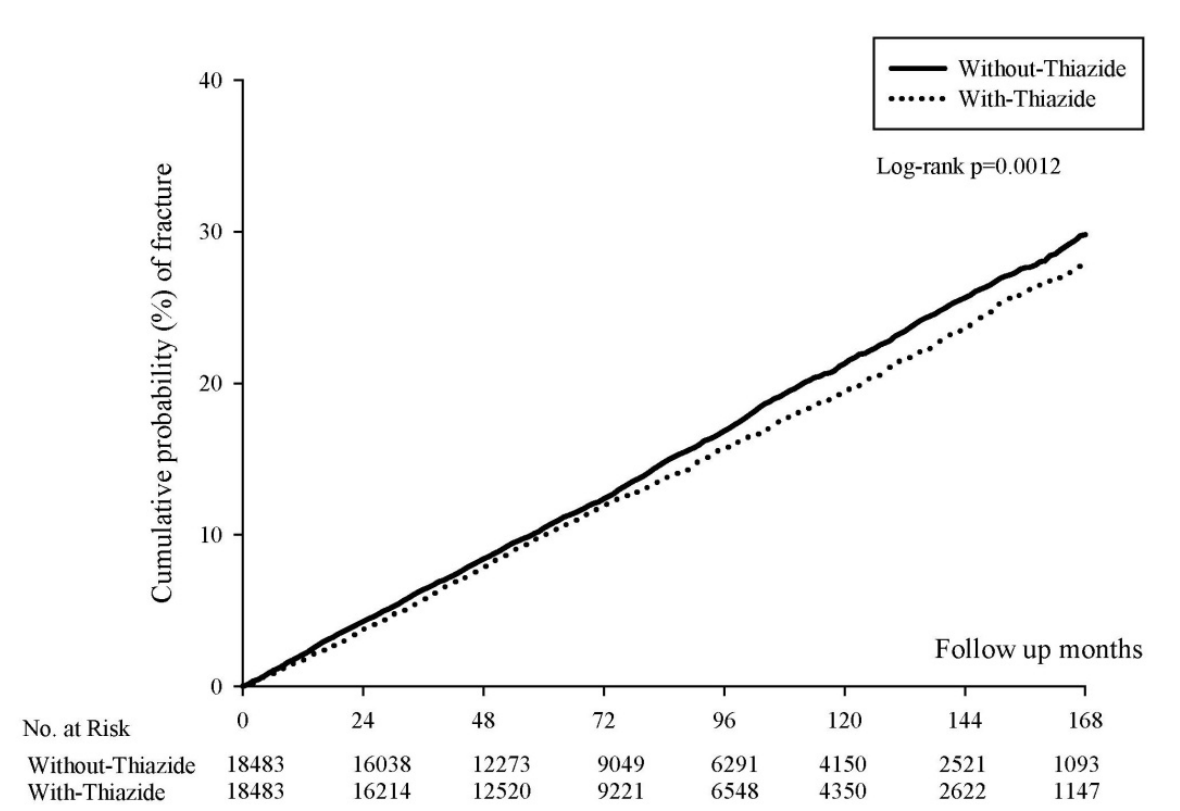
Figure 2. Kaplan–Meier curves of the cumulative proportions of fracture in the use of thiazide and without the use of thiazide.